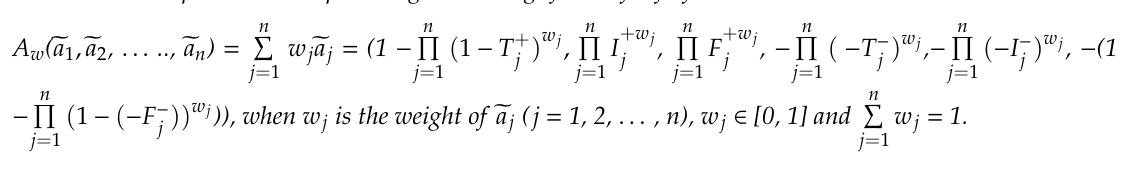
Table 4. Mutuality through criteria.